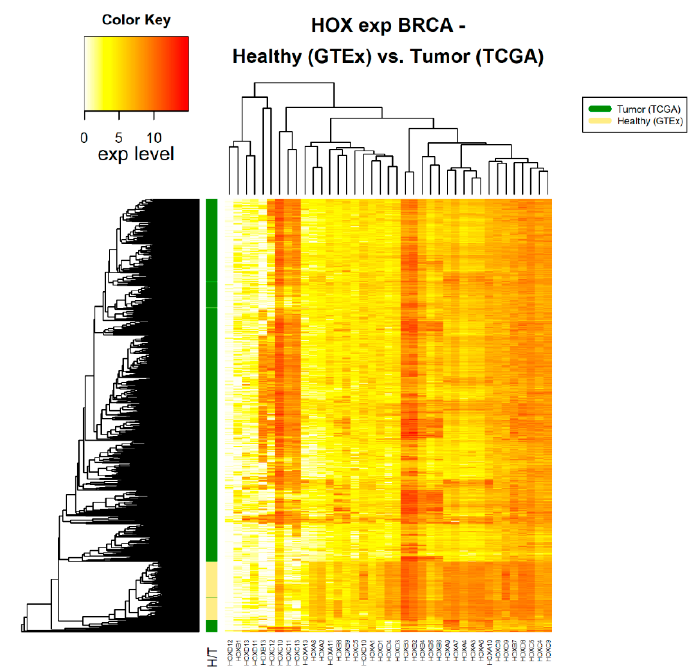
Figure 1. HOX gene expression in healthy and tumor breast tissue samples. The source of expression data of both healthy and tumor samples is TCGA.